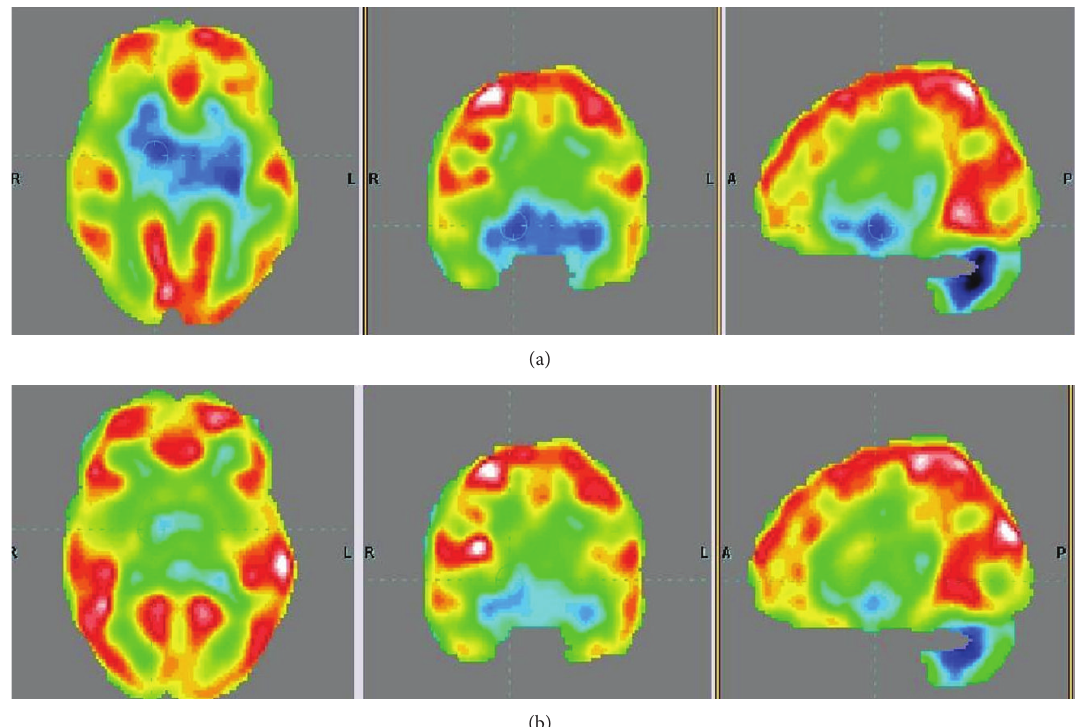
Figure 4: Findings in PET-CT scan before and after cellular therapy. (a) PET-CT scan before intervention showing reduced FDG uptake in the areas of frontal lobe, cerebellum, amygdala, hippocampus, parahippocampus, and mesial temporal lobe. (b) PET-CT scan six months after intervention comparison shows increased FDG uptake in the areas of frontal lobe, cerebellum, amygdala, hippocampus, parahippocampus, and mesial temporal